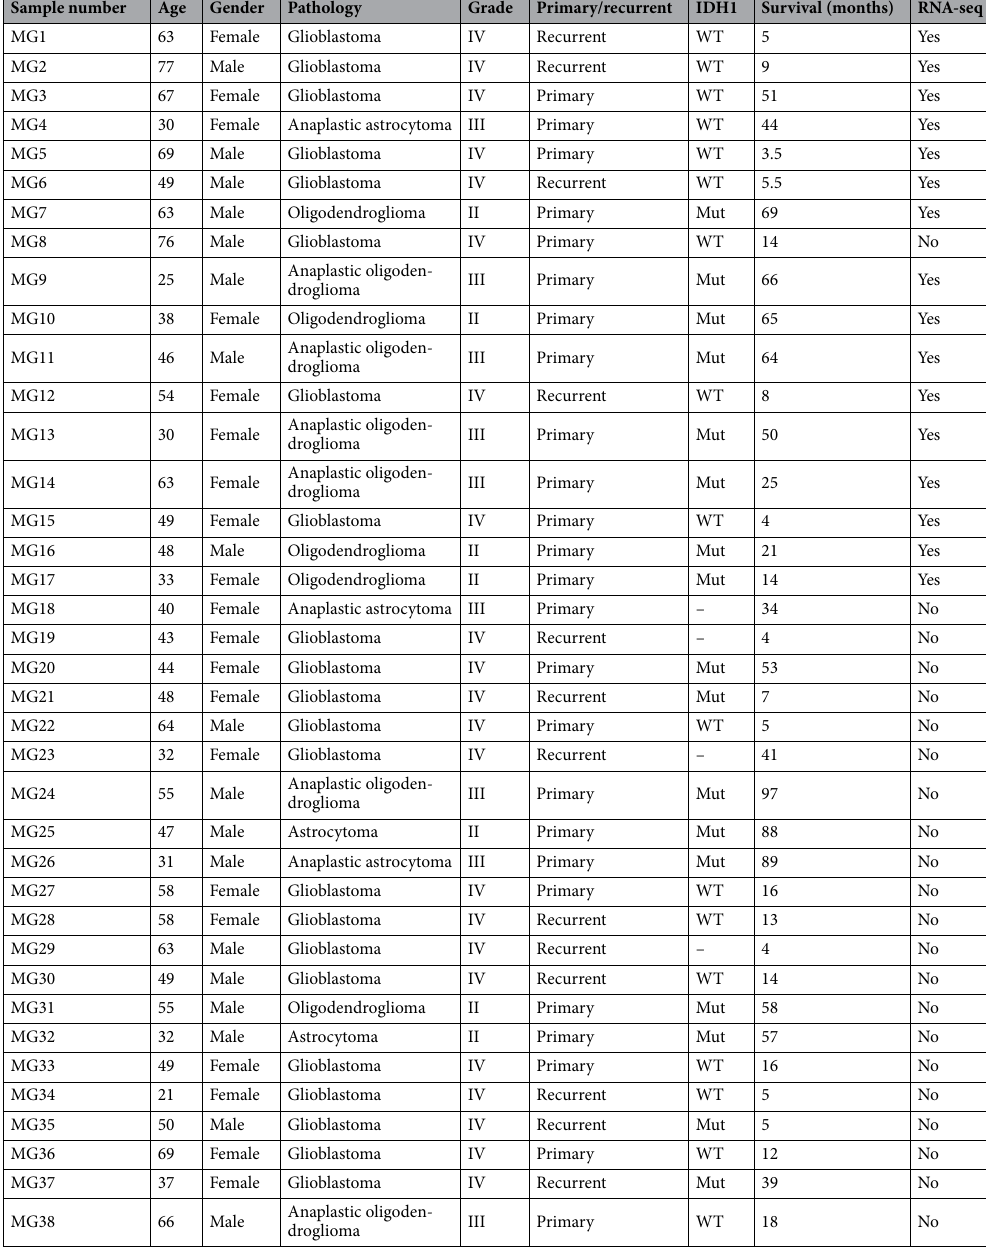
Table 1. Demographic and clinical information for 38 glioma specimens spanning all grades (Grade II-7 specimens, Grade III-9 specimens, Grade IV prary-9 specimens, Grade IV recurrent-13 specimens). Seventeen specimens were determined to have an IDH1 mutation, 17 specimens were determined to be IDH1 wildtype. In four specimens, the IDH1 mutant status could not be determined. The collection includes three paired specimens in which a single patient underwent two surgeries (MG 18/MG19, MG20/MG21, MG27/28). Sixteen samples were of sufficient quality to allow RNA-sequencing